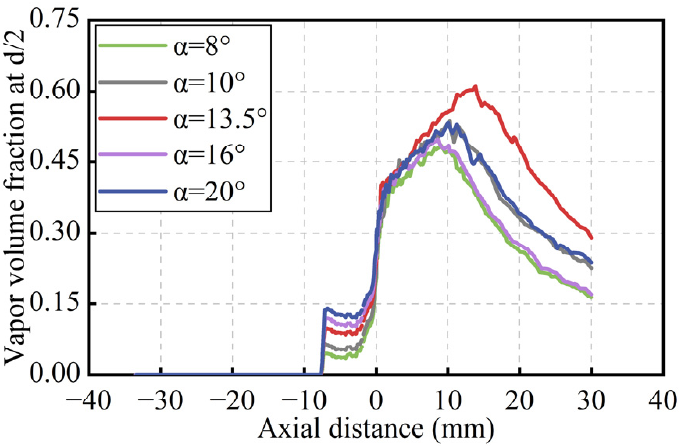
Figure 17. Effect of α on the cavitation.